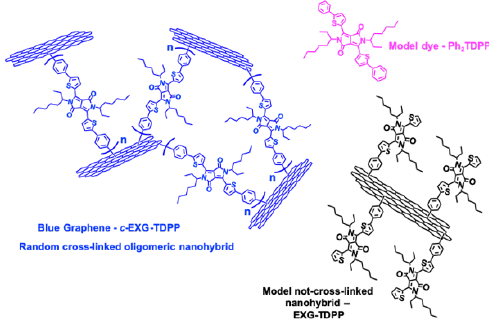
Figure 1: Structure of the cross-linked graphene- dithiophenediketopyrrolopyrrole hybrid c-EXG-TDPP, of the model Ph 2 TDPP chromophore unit constituting its cross-linking oligomers, and of the analogous hybrid system lacking cross-linking